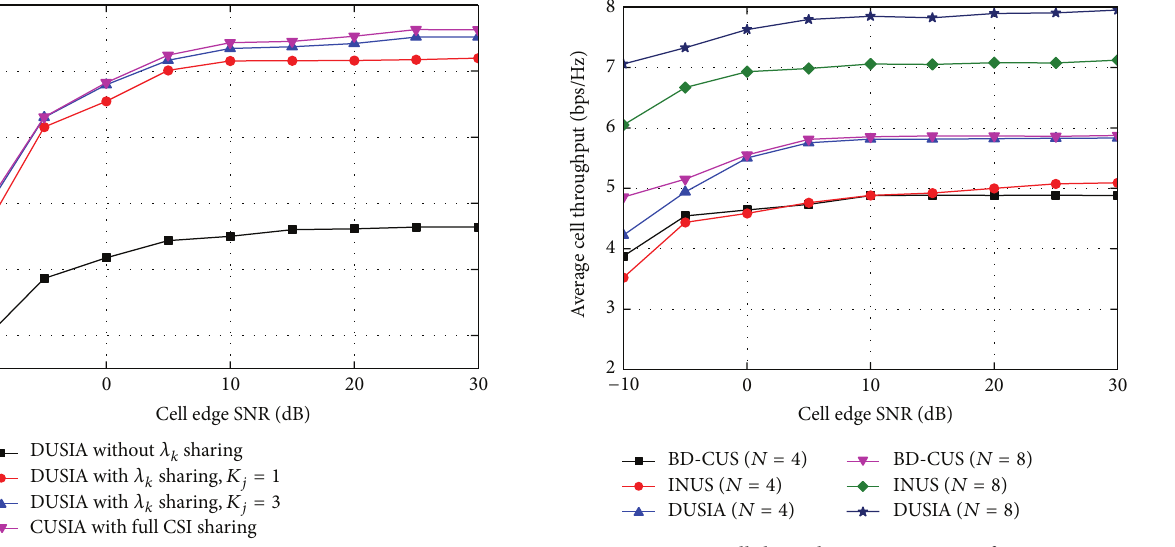
Figure 3: Cell throughput comparison of DUSIA with different level of information sharing, 𝑁 = 4 , 𝜉 = 1 , 10 users per cell.